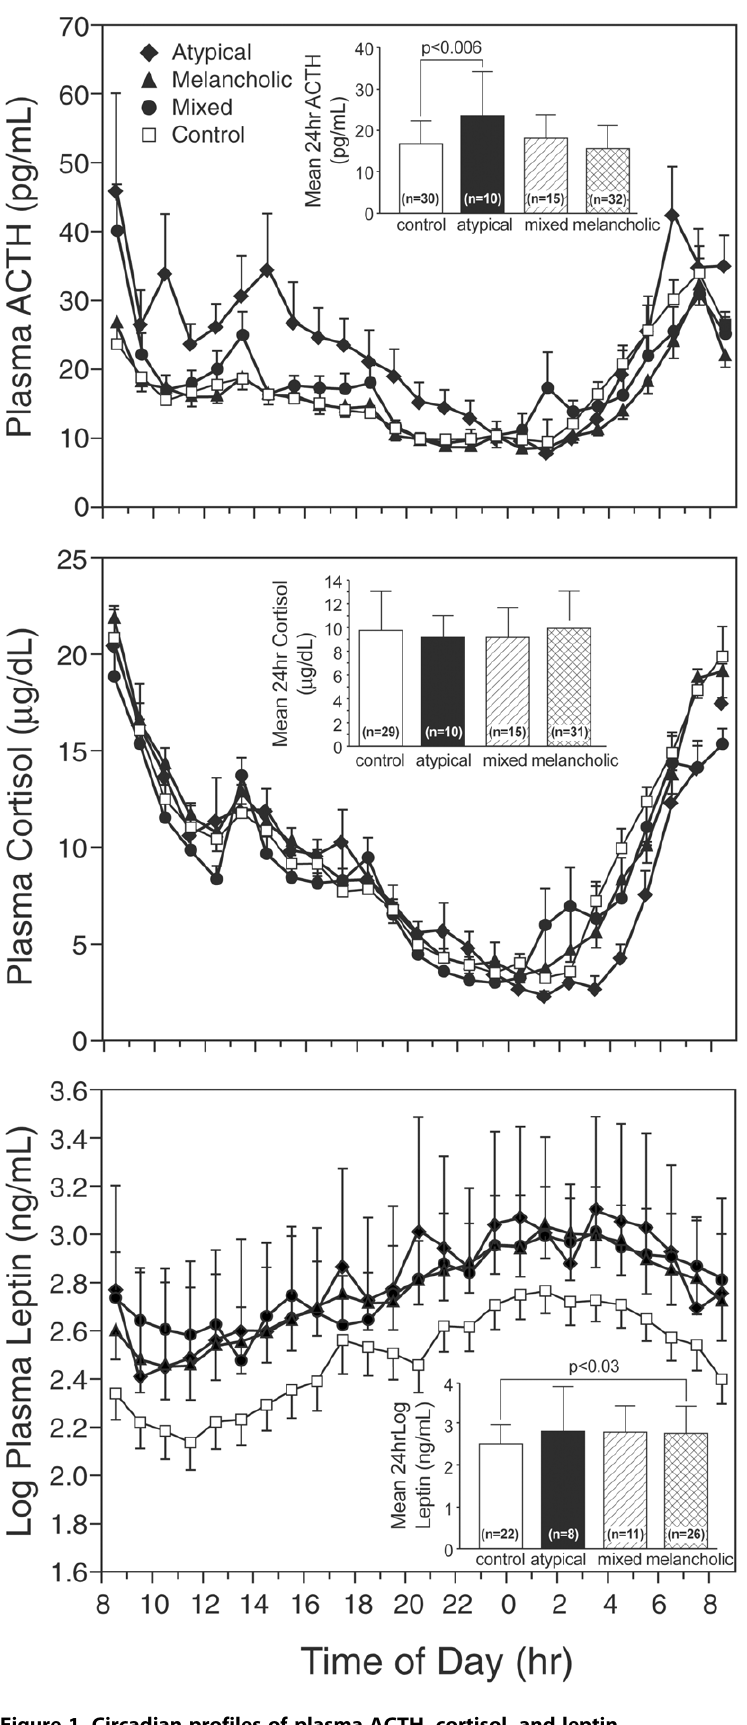
Figure 1. Circadian profiles of plasma ACTH, cortisol, and leptin. doi:10.1371/journal.pone.0028912.g001 PLoS ONE |